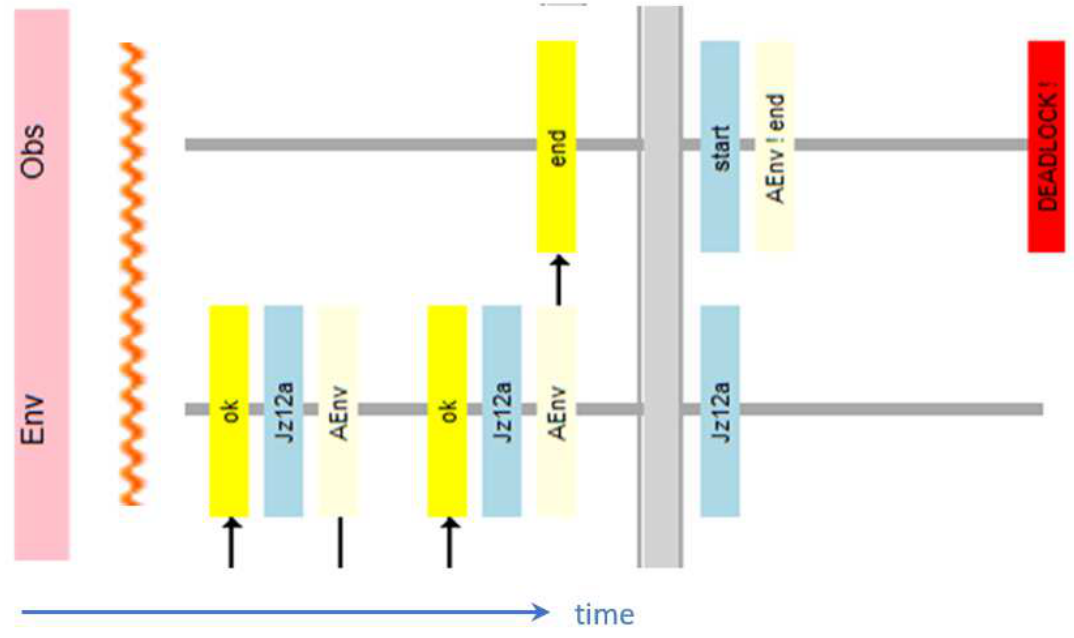
Figure 16. Counter-example for the study of freedom from system deadlock—final fragment.